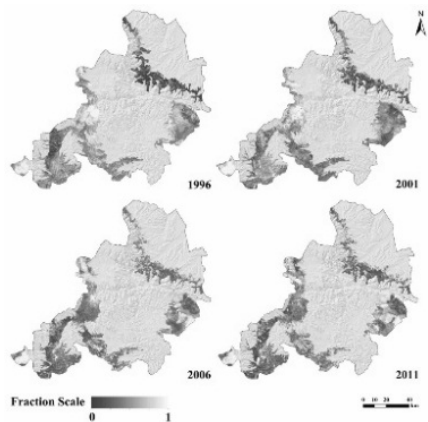
Figure 3. Bare ‐ land fractional results for the four years, with light areas on the maps indicating bare ‐ land covered regions.